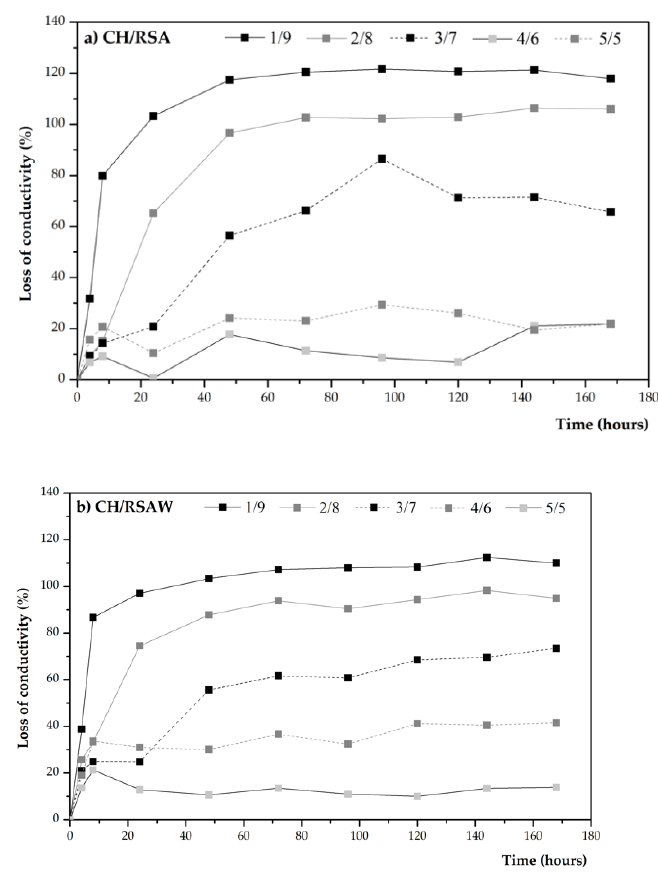
Figure 7. Loss of conductivity versus time tested at 60 ◦ C: ( a ) lime/rice straw ash (CH/RSA) mixtures; ( b ) CH/RSAW mixtures.